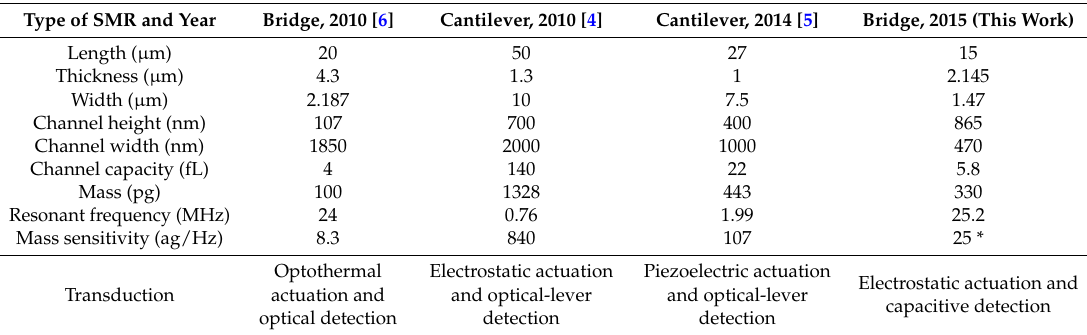
Note: * Estimated mass sensitivity.